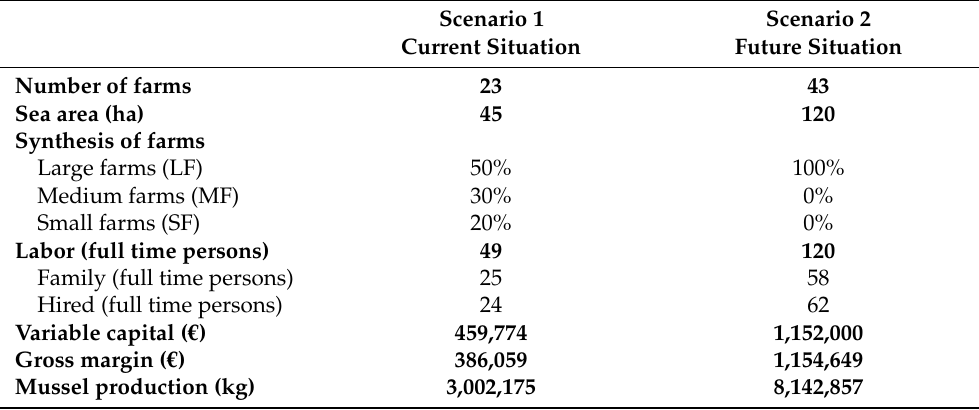
Table 4. Results of the LP model under the two different